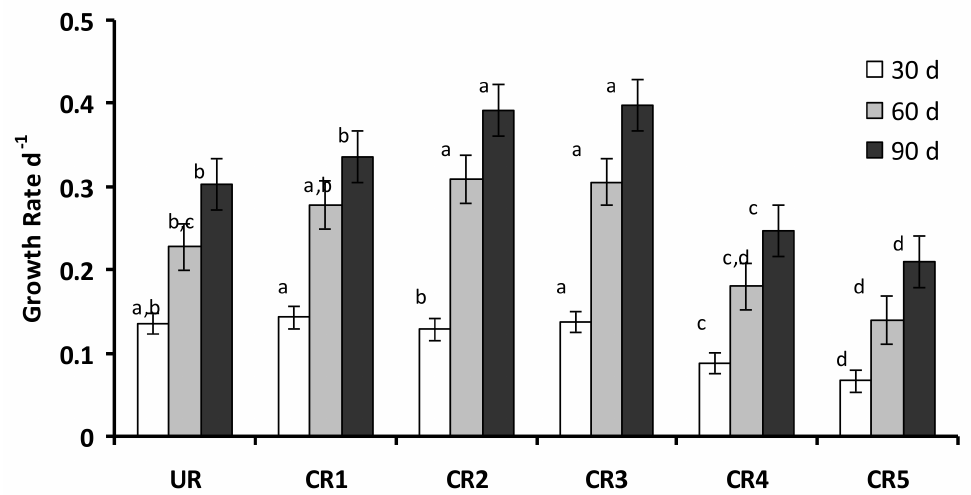
Figure 3. Relative growth rate of C. cajan at various POS concentrations. Different letters indicate growth at various POS concentrations at various periods that were significantly different based on Tukey post hoc analysis ( p < 0.05). Bars represent means ± standard deviation ( n = 3). UR is an uncontaminated rhizosphere and CR 1 to CR5 represent contaminated rhizosphere with POS from 1 to 5% w / w